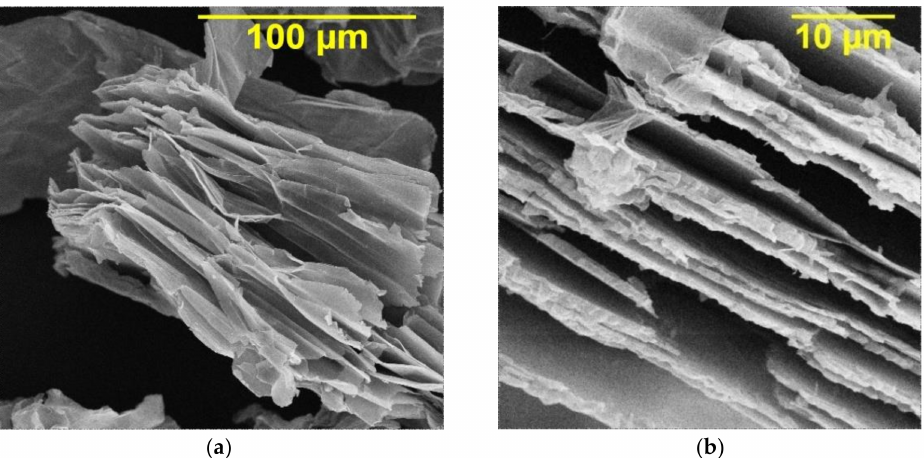
Figure 2. SEM images of the graphene oxide structure with various magnifications: × 1000 ( a ) and × 5000 ( b